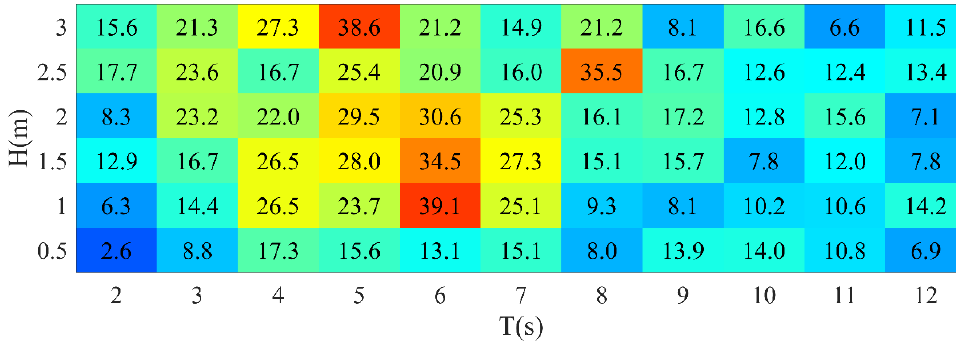
Figure 11. Power generation efficiency of NS-PWEC under irregular wave sea conditions.